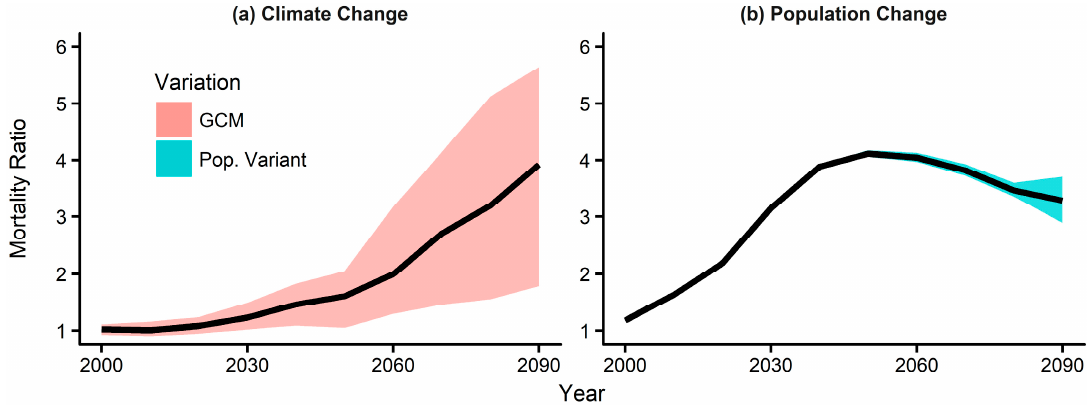
Figure 2. Projections of summer temperature-attributable mortality ratio (MR) in seven major cities of South Korea until the 2090s based on ( a ) climate under RCP 8.5 and ( b ) population changes. The red and blue shaded areas show the variations in the MR projections due to uncertainties in climate and population changes, respectively.